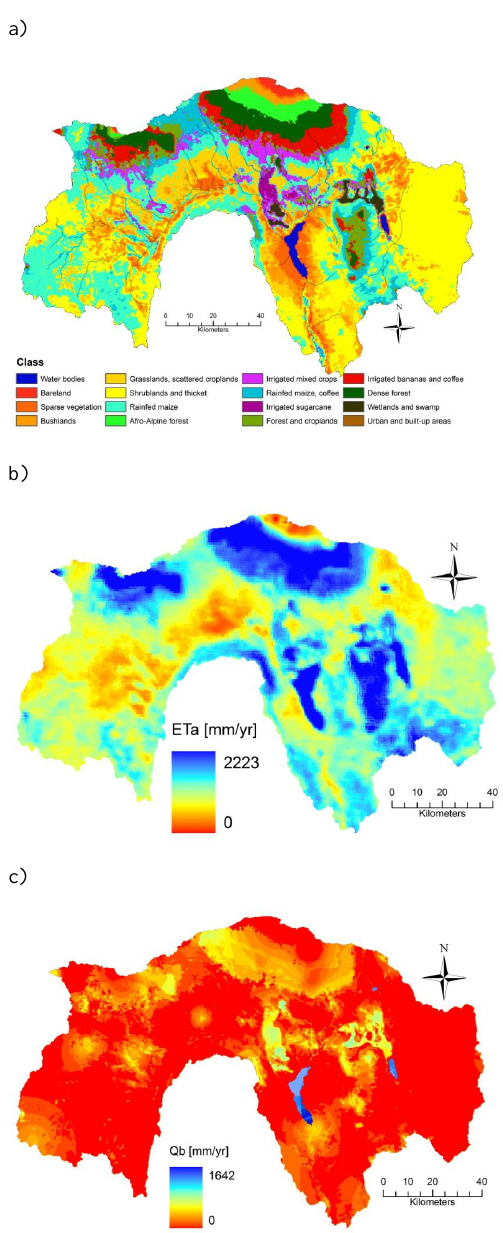
Figure 8. Spatial variability of (a) land use map (Kiptala et al., 2013a); (b) ET a averaged for 2008–2010 (Kiptala et al., 2013b); and (c) blue water use ( Q b ) averaged over 2008–2010 in the upper Pangani River basin.